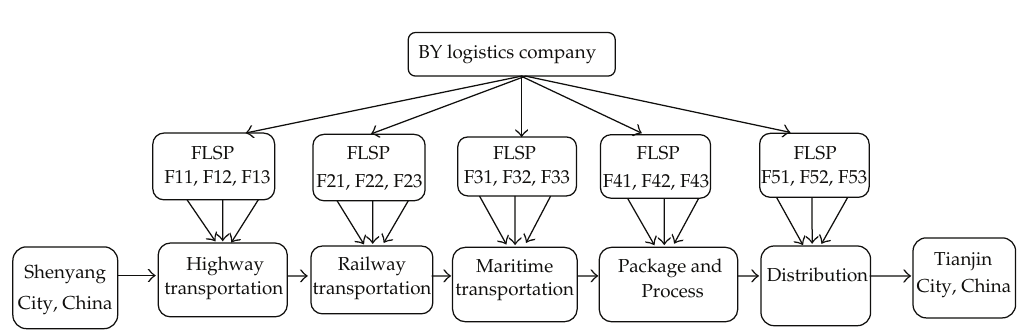
Figure 1: The logistics service process of one order of BY